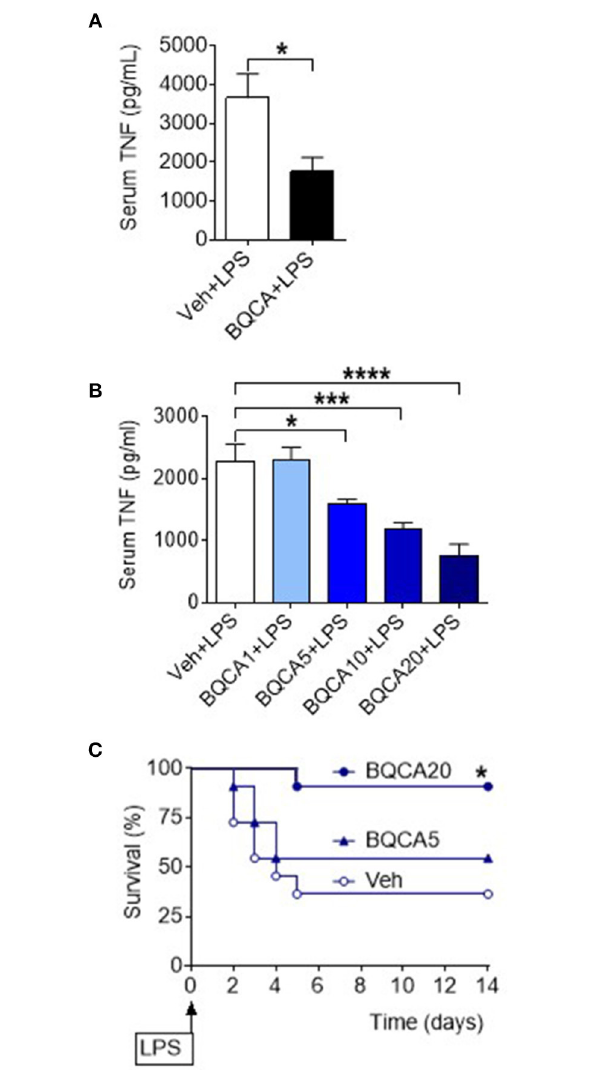
FIGURE 3 | Activation of acetylcholine action on the M1 mAChR using a positive allosteric modulator (BQCA) suppresses serum TNF levels and improves survival in endotoxemia. (A) BQCA (5 µ /kg, i.c.v.) suppresses serum TNF (* P = 0.018, unpaired two-tailed Student’s t test), n = 6–7 per group. (B) Peripheral i.p. administration of BQCA 1–20 (1–20 mg/kg) in endotoxemic mice suppresses serum TNF levels (* P = 0.027, *** P = 0.0005, **** P < 0.0001, one-way ANOVA, Dunnett’s multiple comparisons test), n = 7–8 per group. (C) Peripheral i.p. administration of BQCA 20 (20 mg/kg)